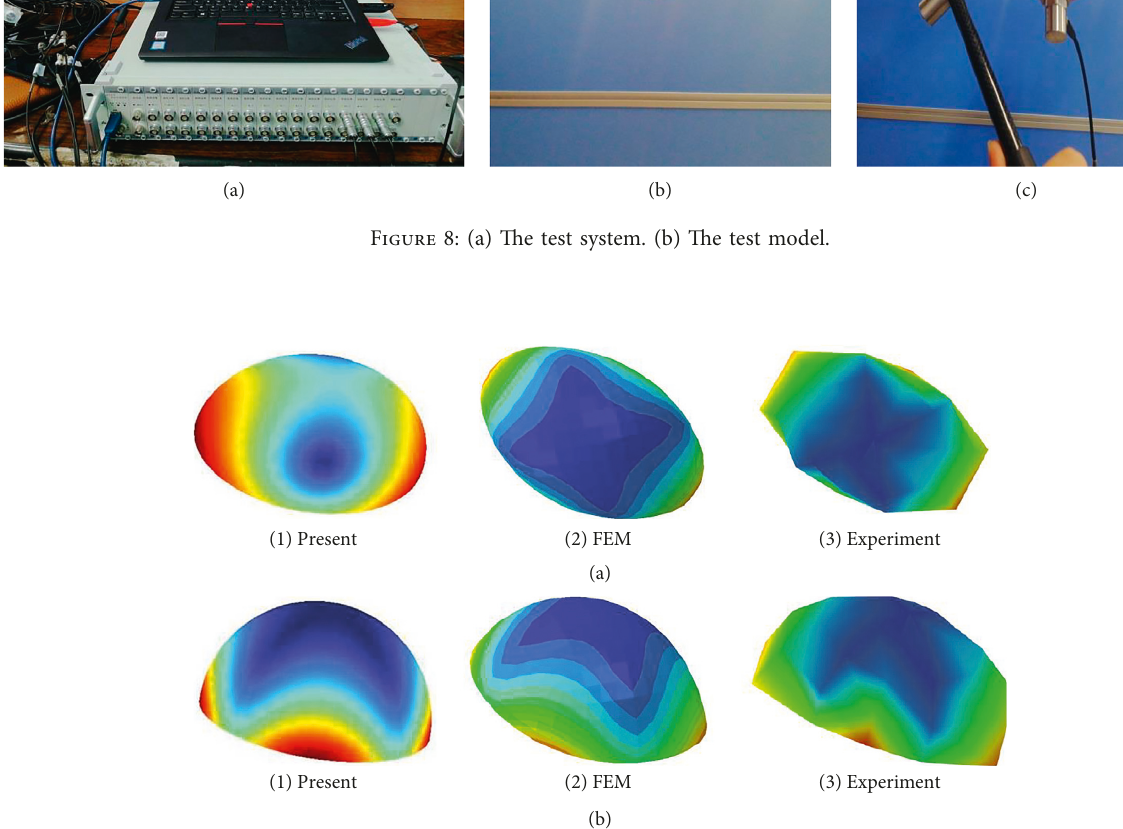
1, m 1). (cid:29) (cid:29)